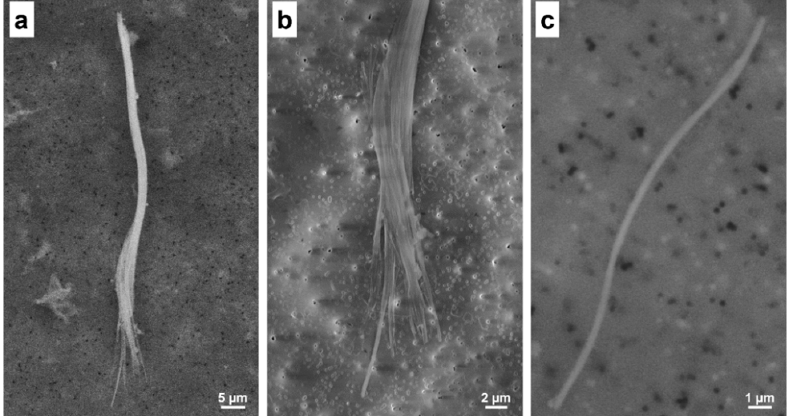
Figure 3. Fibers and bundles of fibers observed in digested neoplastic tissue. ( a ) Bundle of fibers observed in the neoplastic tissue. ( b ) Magnification of the top of the bundle, showing separation of the different fibers, as expected in the asbestos minerals. ( c ) Typical single fiber detected in the neoplastic